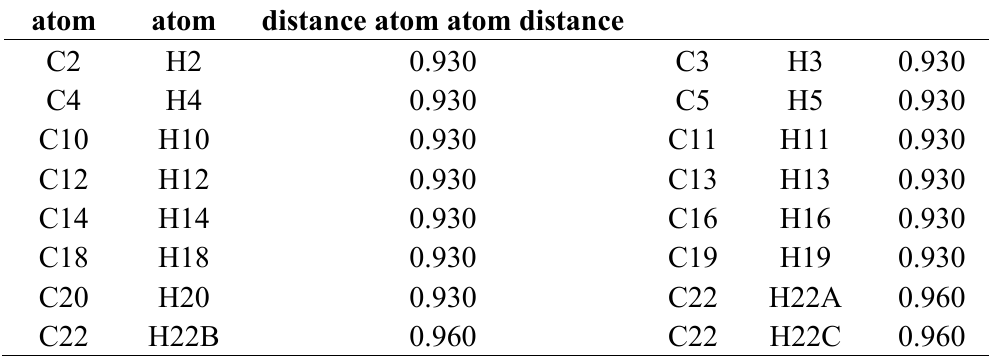
Table 11. Bond lengths involving hydrogen's (Å) for compound 10